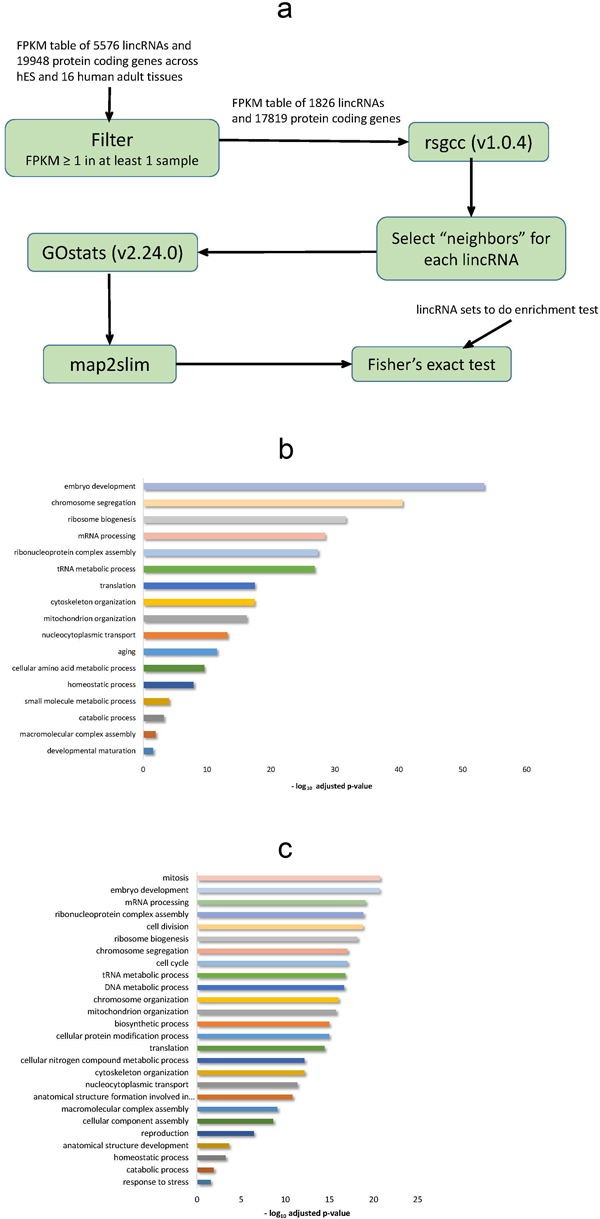
Function annotation of human lincRNAs. (a) flowchart of co-expression association annotation. Expression profile across hES and 16 human adult tissues was filtered for low expressed genes. Then, Gini correlations were calculated and neighbors of each lincRNA were selected to do GO enrichment analysis. We got a list of enriched GO slim terms and their corresponding lincRNAs by mapping GO terms to GO slim terms. Finally, we did Fisher's exact test to test whether interested lincRNA sets were enriched in each GO slim terms. Please see details in GO enrichment analysis section in Data Preparation of Methods and Materials. (b) Significantly enriched biological processes of hES lincRNAs, (c) hES biased lincRNAs.